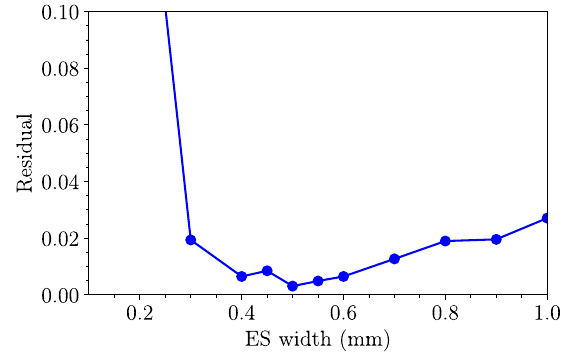
FIG. 14. Residual between measured and best-fit 2D simulated normalized total loss as a function of the ES width.